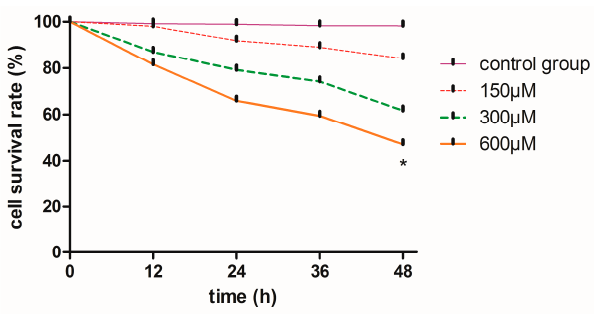
Figure 1. Effects of simazine on mouse dopaminergic progenitor neurons (MN9D) viability was assessed by Cell Counting Kit (CCK)-8 assay. Data represent absorbance values as percentages of untreated control cells, * statistically significant difference compared with the control, * p < 0.05, 3 repeated experiments for each group, n = 3.